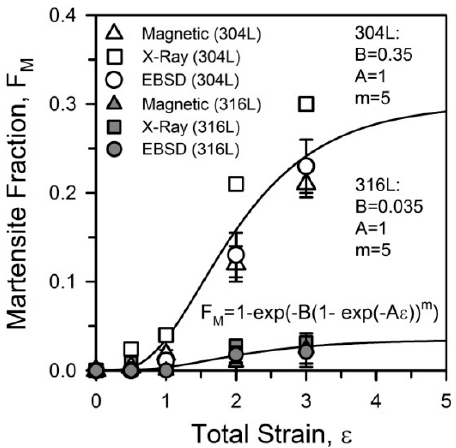
Figure 7. The martensite fraction in 304L and 316L stainless steels subjected to rolling at 473 K to various total strains ( ε ).